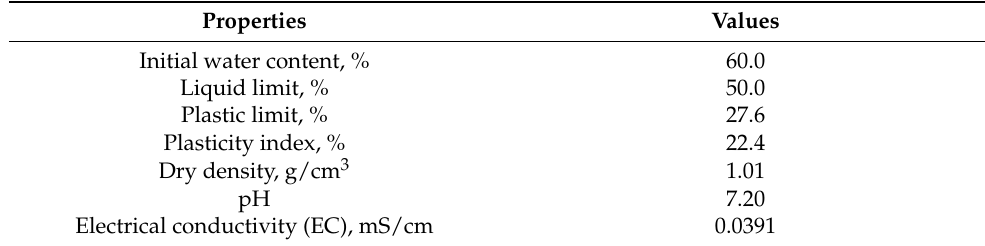
Figure 1. Location of dredged sediment sludge. Table 1. The basic physical properties of dredged